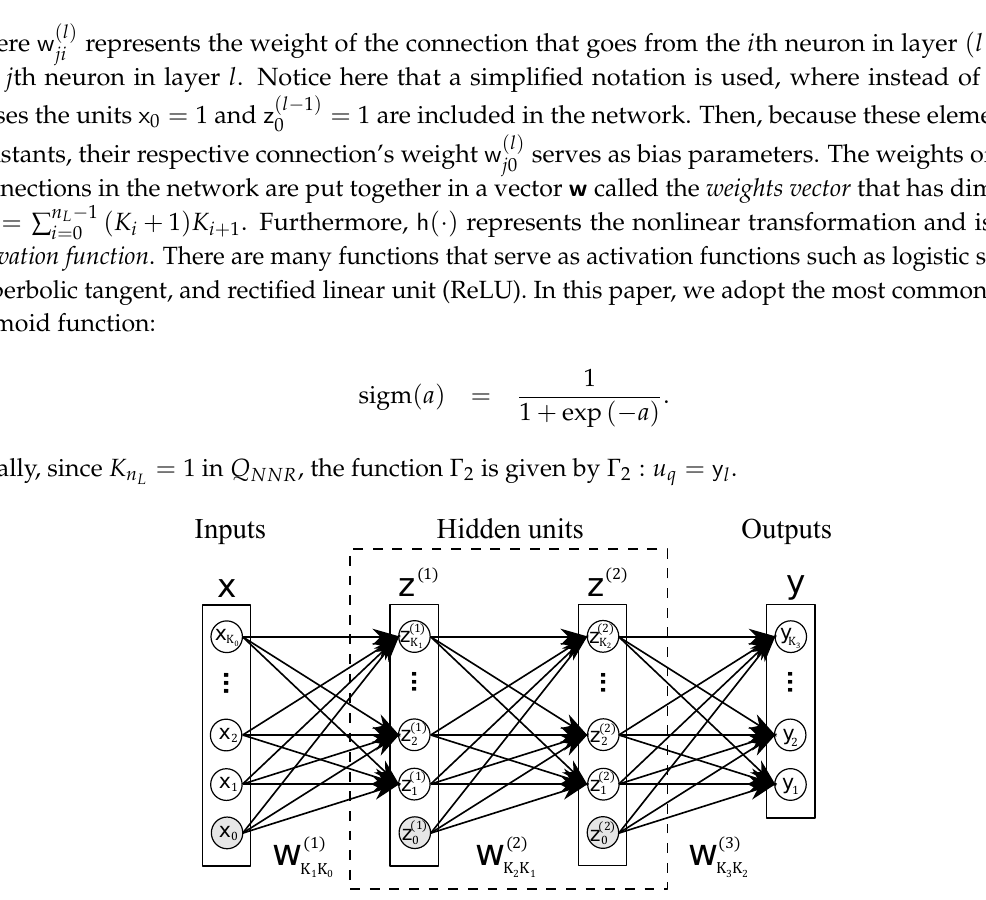
Figure 4. Fully connected 3 layered feed-forward neural network